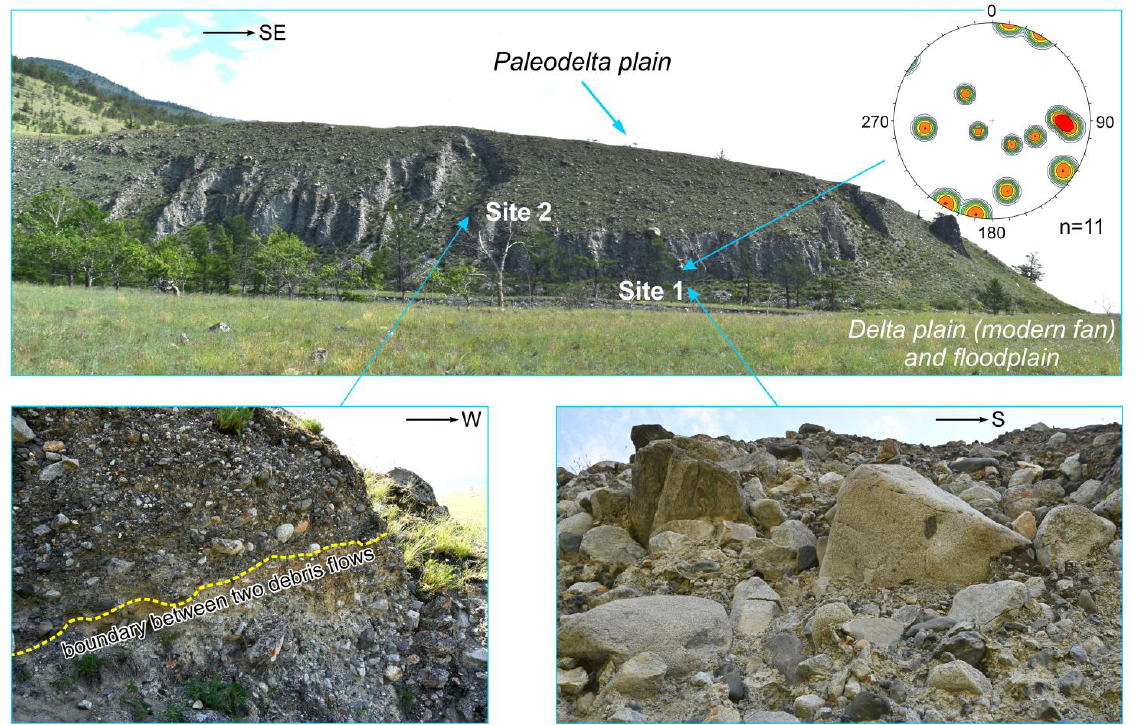
Figure 6. Debris flow deposits in sites 1 and 2 (see location in Figure 4) and diagram of the fractures in clasts (equal angle upper hemisphere projection; n —number of measurements; counting circle size 1%; intensity isolines are 1, 2, 3 and >; different colors show density concentration from 0 (white) to > 9 (red)).